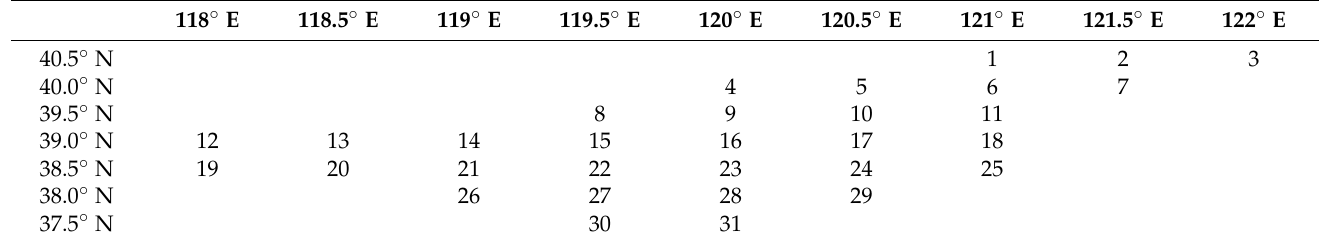
Table 1. Geographic locations and numerical designations (ID) of the 31 research coordinates.